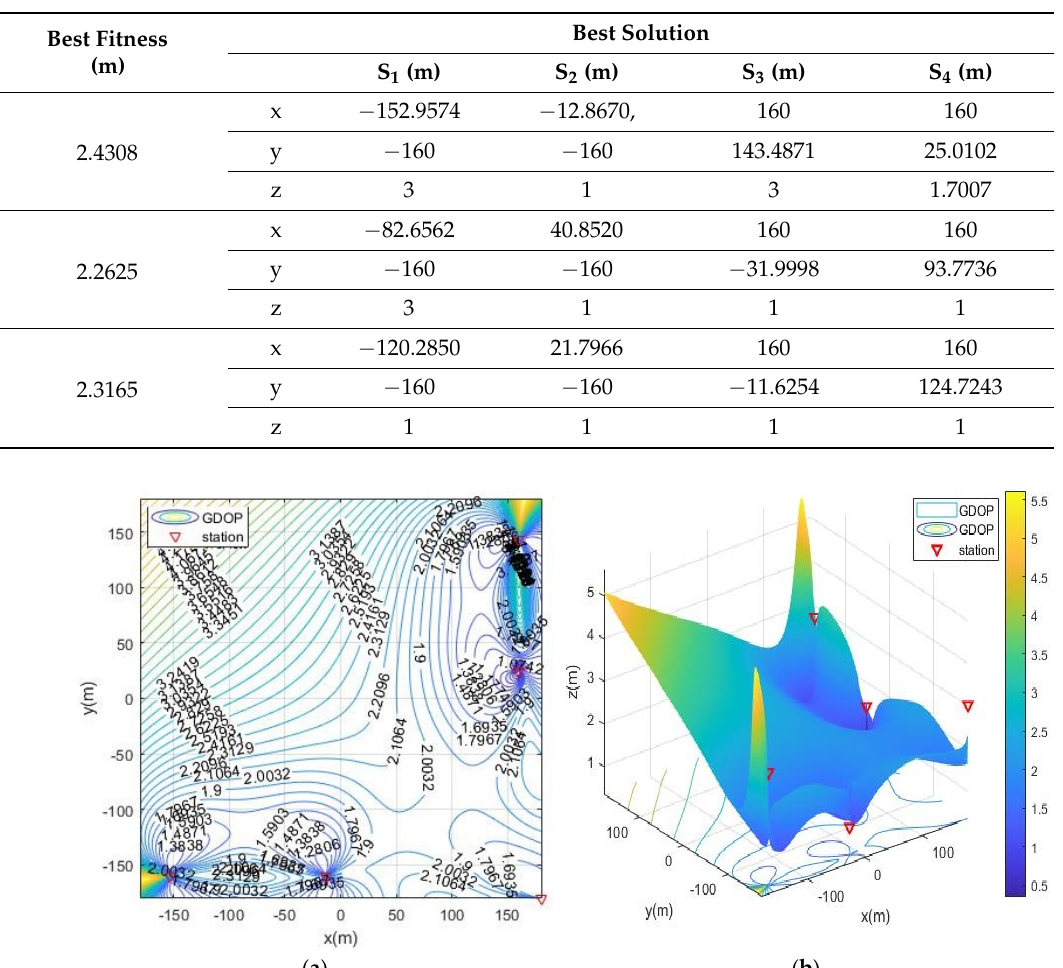
( a ) ( b ) Figure 12. GDOP map of five base stations optimization results with a fixed station (–200, –200, 3) ( a ) 2D contour map of moa06; ( b ) 3D contour map of moa06.